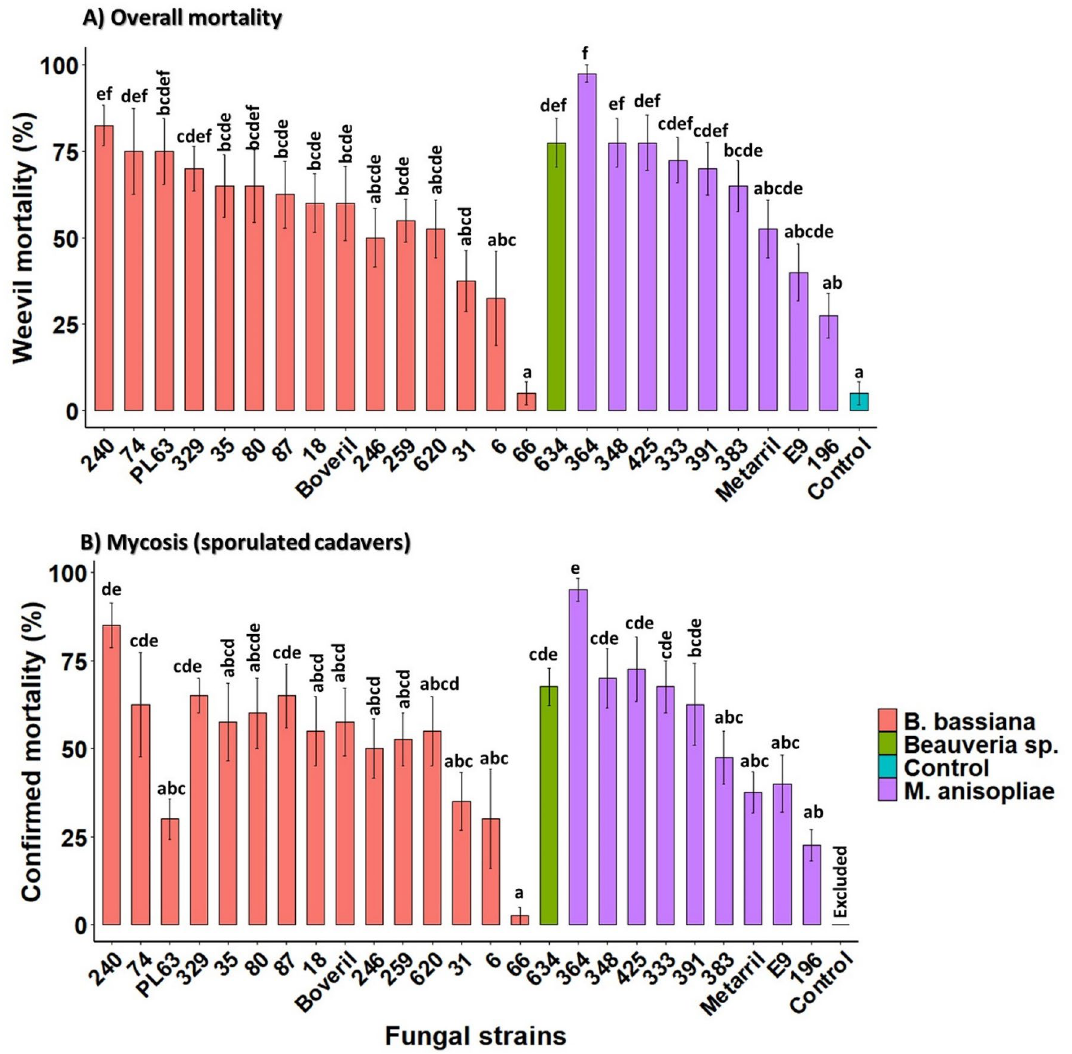
Figure 1. Cumulative mortality rate by day 20 post-spraying ( A ) and confirmed mortality (i.e., sporulated cadavers or mycosis rate [ B ]) of G. platensis adults after inoculation with 1 × 10 8 conidia mL −1 of several strains of M. anisopliae , Beauveria sp. and B. bassiana . Untreated weevils from control group were sprayed only with Tween-80 solution (0.1%). Vertical bars represent means (± SE, n = 8 replicates with a total of 40 weevils per treatment), while different letters denote significant contrasts between treatments by Tukey HSD method ( P < 0.05). There are four commercial strains explored in Brazil and used here as positive controls for the sake of comparison: B . bassiana IBCB-66 (only unformulated) and ESALQ-PL63 (unformulated and formulated as Boveril); M. anisopliae ICBC425 (only unformulated) and ESALQ-E9 (unformulated and formulated as